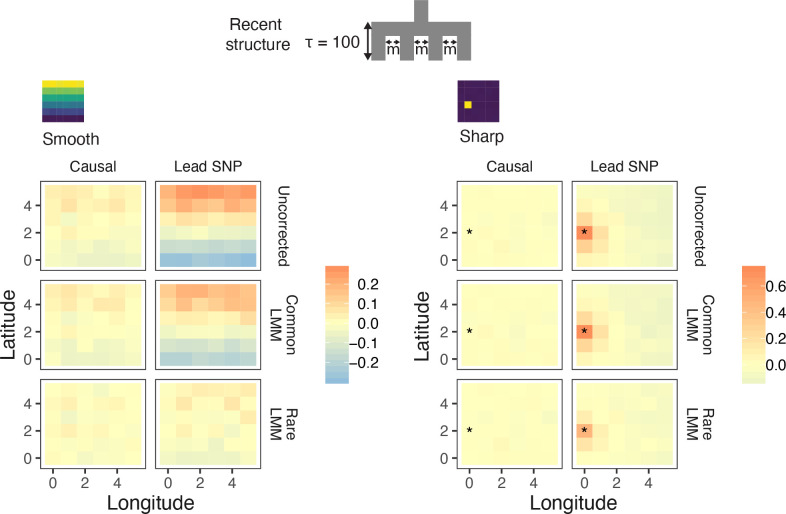
Spatial distribution of residual polygenic scores based on effect sizes from linear mixed models carried out in GCTA-LOCO.Residual polygenic score in each deme was averaged across all individuals from that deme and over 10 simulations of the phenotype. The terms 'Causal' and 'Lead SNP' refer to polygenic scores constructed with known causal variants and topmost significant SNPs, respectively.